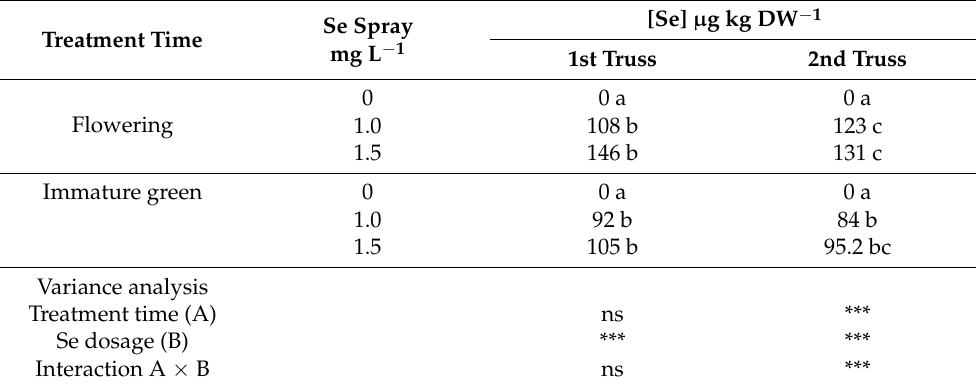
Table 1. Selenium concentration ( µ g kg − 1 DW) in tomato fruit sprayed with sodium selenate (Na 2 SeO 4 ) at different selenium concentrations and distributed at FL and fruit IG stages. Se Spray Treatment Time